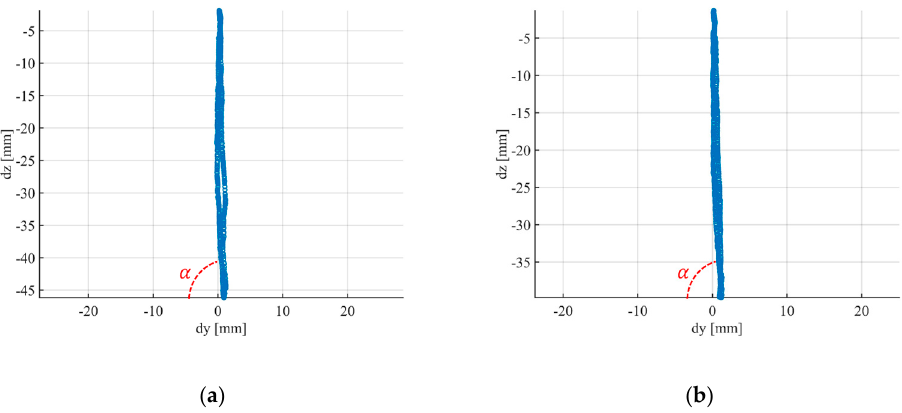
Figure 18. Displacement axis of the target at y = 85.9 m ( a ) and of the target at y = 99 m ( b ).